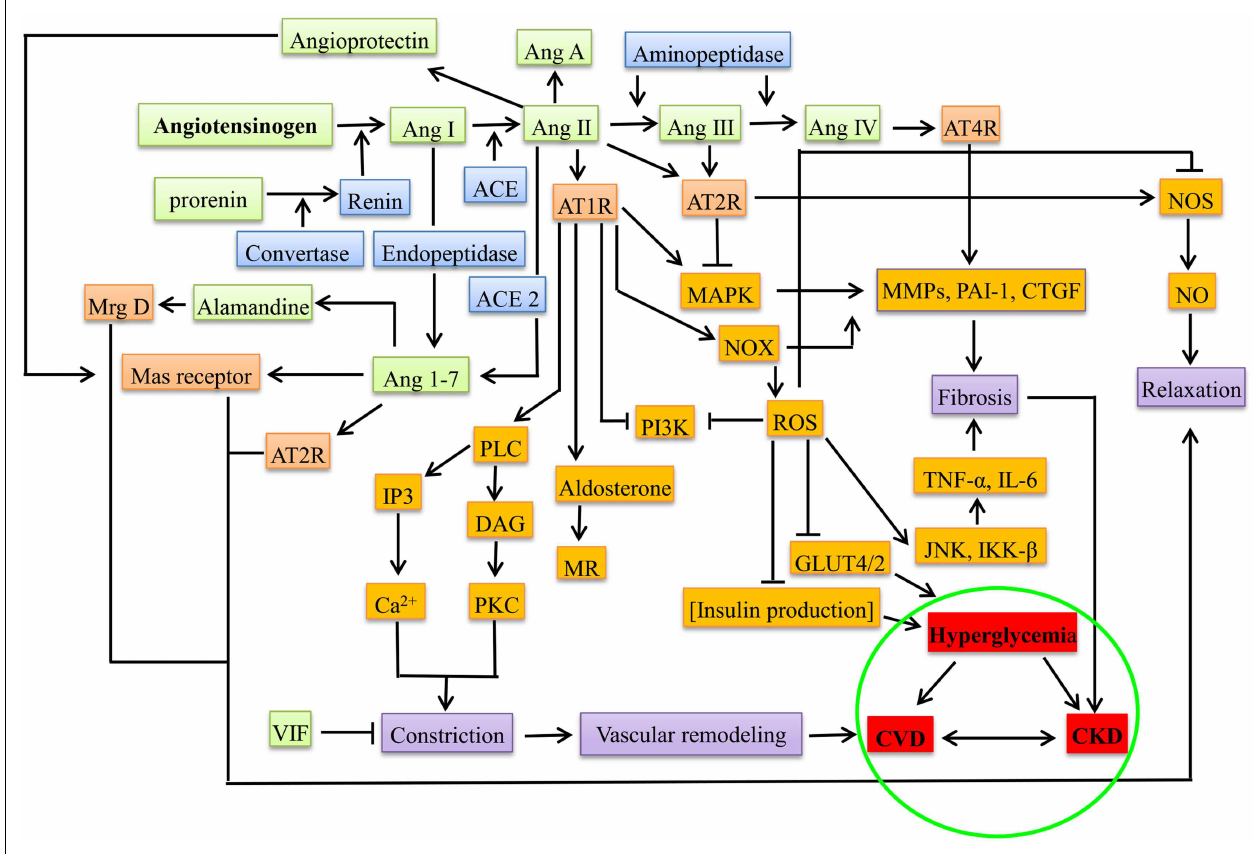
inducing factor; PLC, phospho lipase C; DAG, diacyl glycerol; IP3, inositol triphosphate; PKC, protein kinase C; MR, mineralocorticoid receptor; PI3K, phosphoinositide 3-kinase; MAPK, mitogen-activated protein kinase; NOX, NADPH oxidase; ROS, reactive oxygen species; MMPs, matrix metalloproteinases; PAI-1, plasminogen activator inhibitor-1; CTGF, connective tissue growth factor; TNF- α , tumor necrosis factor alpha; JNK, c-Jun N-terminal kinases; IKK- β , inhibitor of nuclear factor-kappa-B kinase; NOS, nitric oxide synthase; CVD, cardiovascular disease; CKD, chronic kidney